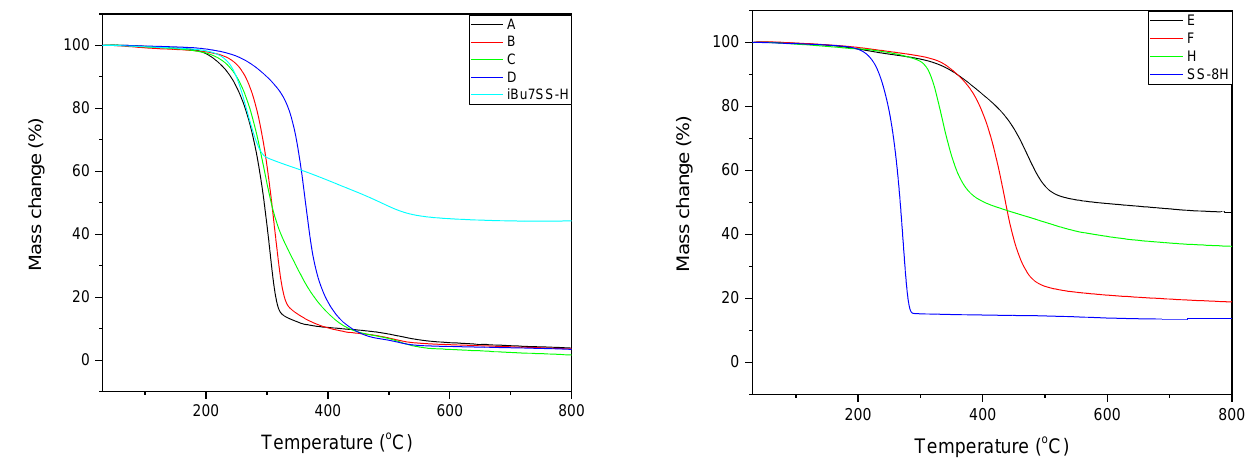
Molecules 2021 , 26 , x FOR PEER REVIEW Figure 6. TGA curves of iBu 7 SS-H and SS-8H and its derivatives. Figure 6. TGA curves of iBu 7 SS-H and SS-8H and its derivatives. Table 2. Summary of the data from the conducted measurements: the beginning of the decomposition process (onset). Sample